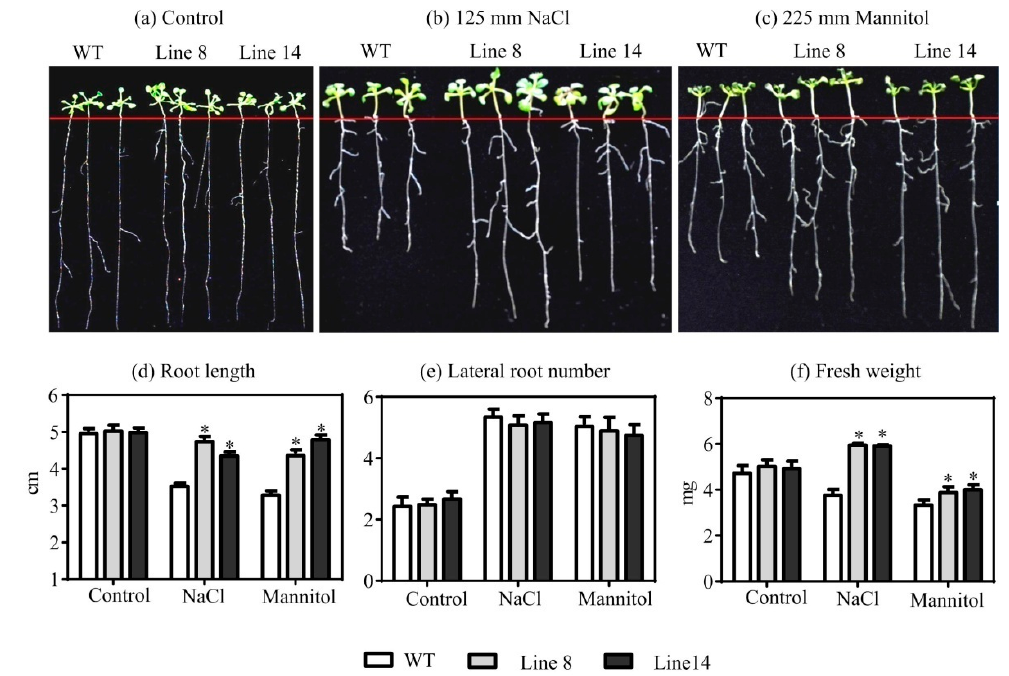
Figure 3. The seed germination percentage and growth of WT and two overexpressing lines of Arabidopsis plants under osmotic and salt stresses. ( a – c ) Phenotypes of WT and two overexpressing lines treated with an MS medium (control) ( a ), MS medium supplied with 125 mm NaCl ( b ), and an MS medium supplied with 225 mm mannitol ( c ) for 7 days. ( d – f ) Effect of different levels of mannitol and NaCl stresses on germination percentage ( d ), root length ( e ), and fresh weight ( f ) of WT and transgenic overexpressing Arabidopsis plants after 7 days. Values are means ± SD (standard deviation). Asterisk indicates a significant difference at the p < 0.05 significance level, as determined with SPSS v. 19.0.